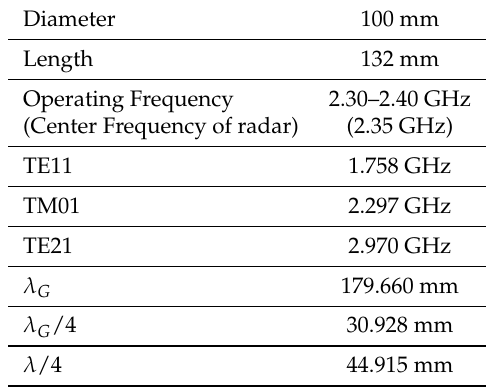
Table 1. Coffee can antenna specification for version